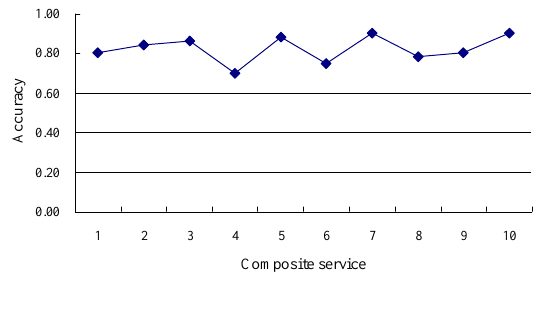
Fig. 4. Accuracy on service searching by the S -